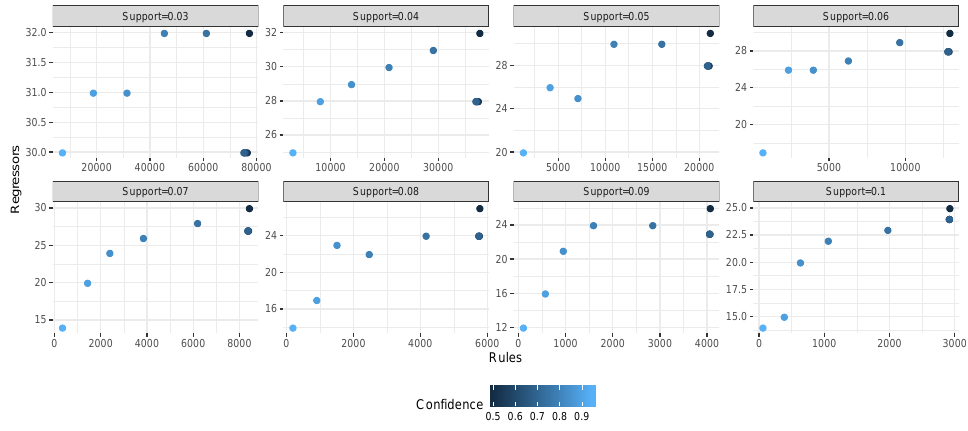
Figure 6. Rules and regressors for each experimental setting.